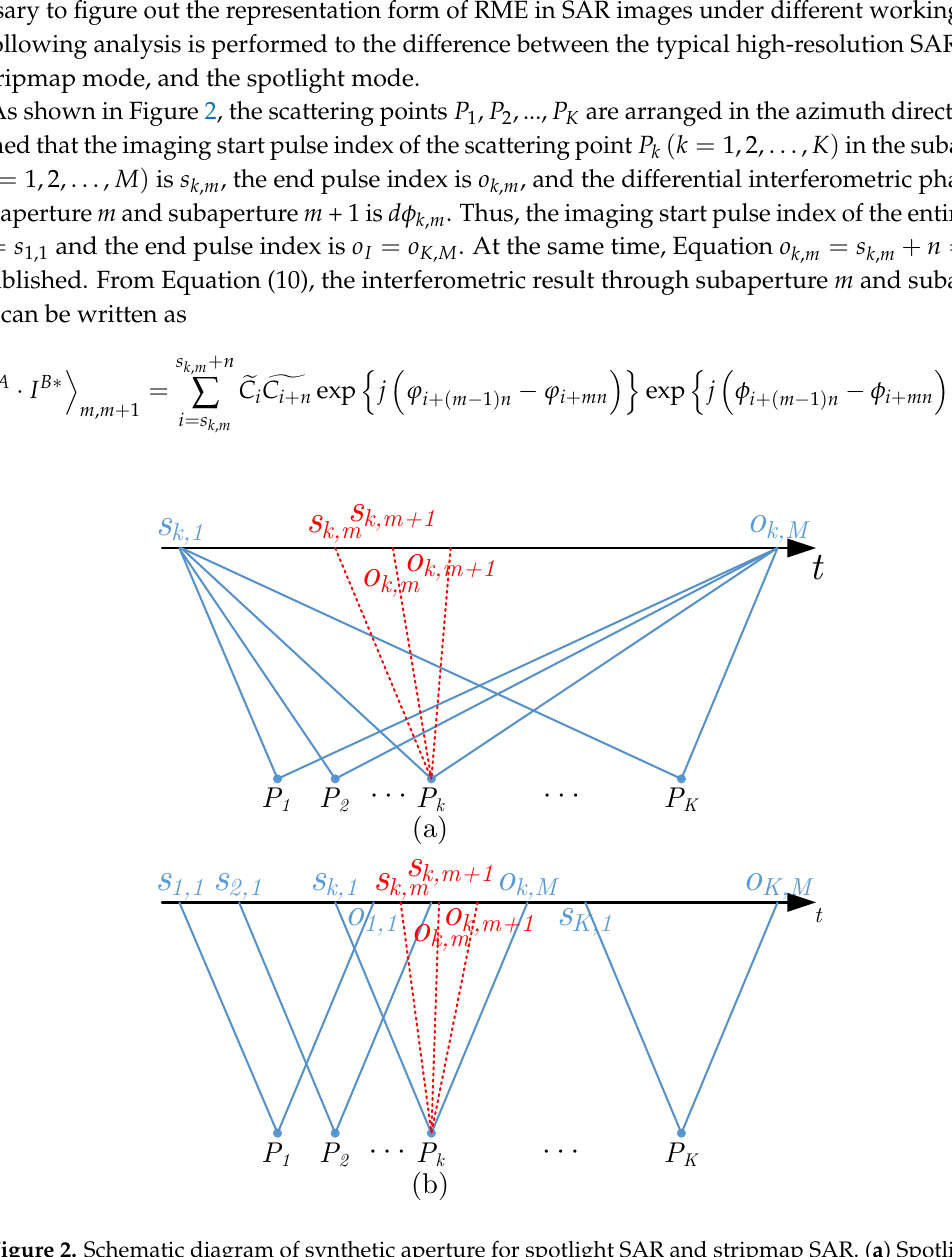
Figure 2. Schematic diagram of synthetic aperture for spotlight SAR and stripmap SAR. ( a ) Spotlight SAR ( b ) Stripmap